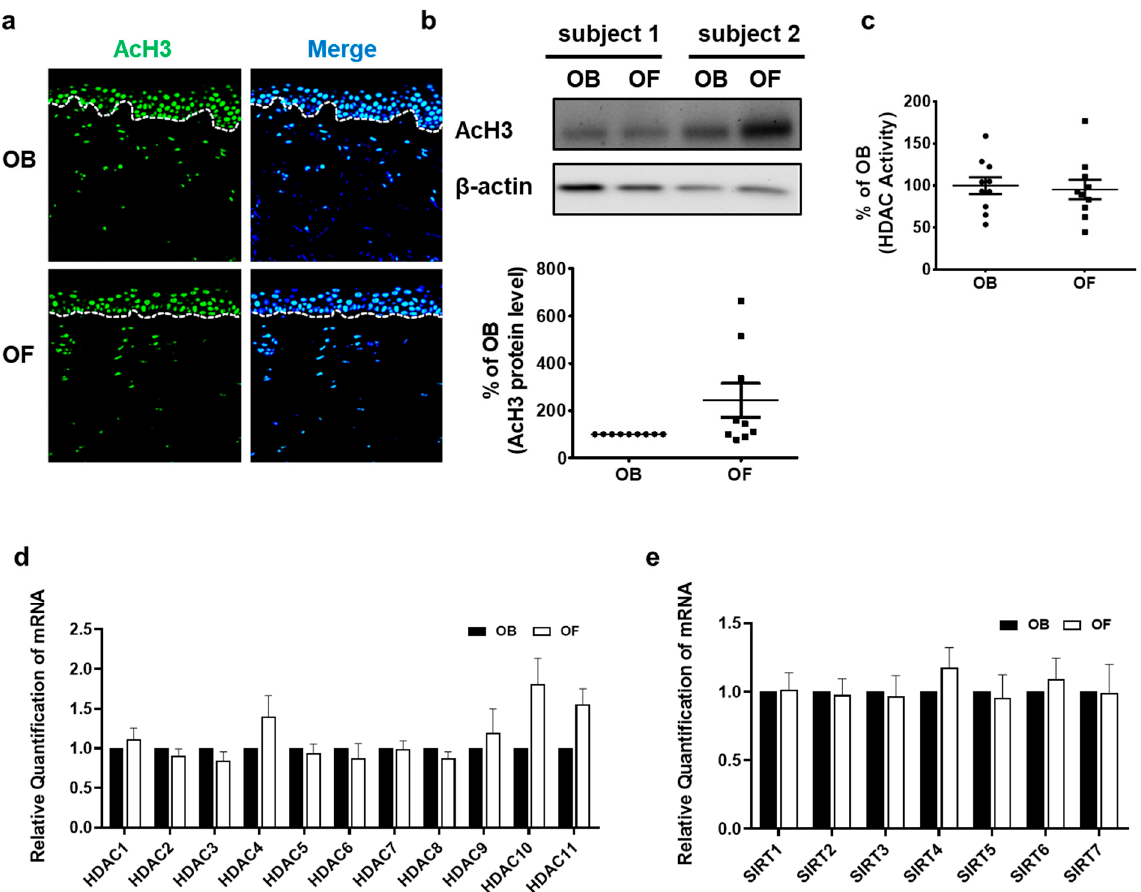
Figure 3. Acetylated histone H3, HDAC activity, and expression of HDACs and SIRTs did not show significant changes in photoaged human skin in vivo. Buttock and forearm skin of the same elderly subjects were obtained by punch biopsy. Immunofluorescence analysis of AcH3 and DAPI ( n = 6). Original magnification: ×200 ( a ). Western blot analysis of AcH3 and β -actin protein ( n = 9). The bands are representative of the results obtained in nine independent experiments ( b ). Total HDAC activity was measured using an HDAC assay kit in control or UV-irradiated human skin tissues ( n = 10) ( c ). Expression levels of HDAC and SIRT mRNAs were compared in buttock and forearm skin of the same aged subjects by qPCR ( n = 10) ( d , e ). Data were normalized to each individual’s buttock skin. The bar graph shows the means ± SEM. Statistical significances were determined using a two-tailed paired t -test. OB: Old buttock skin; OF: Old forearm skin.